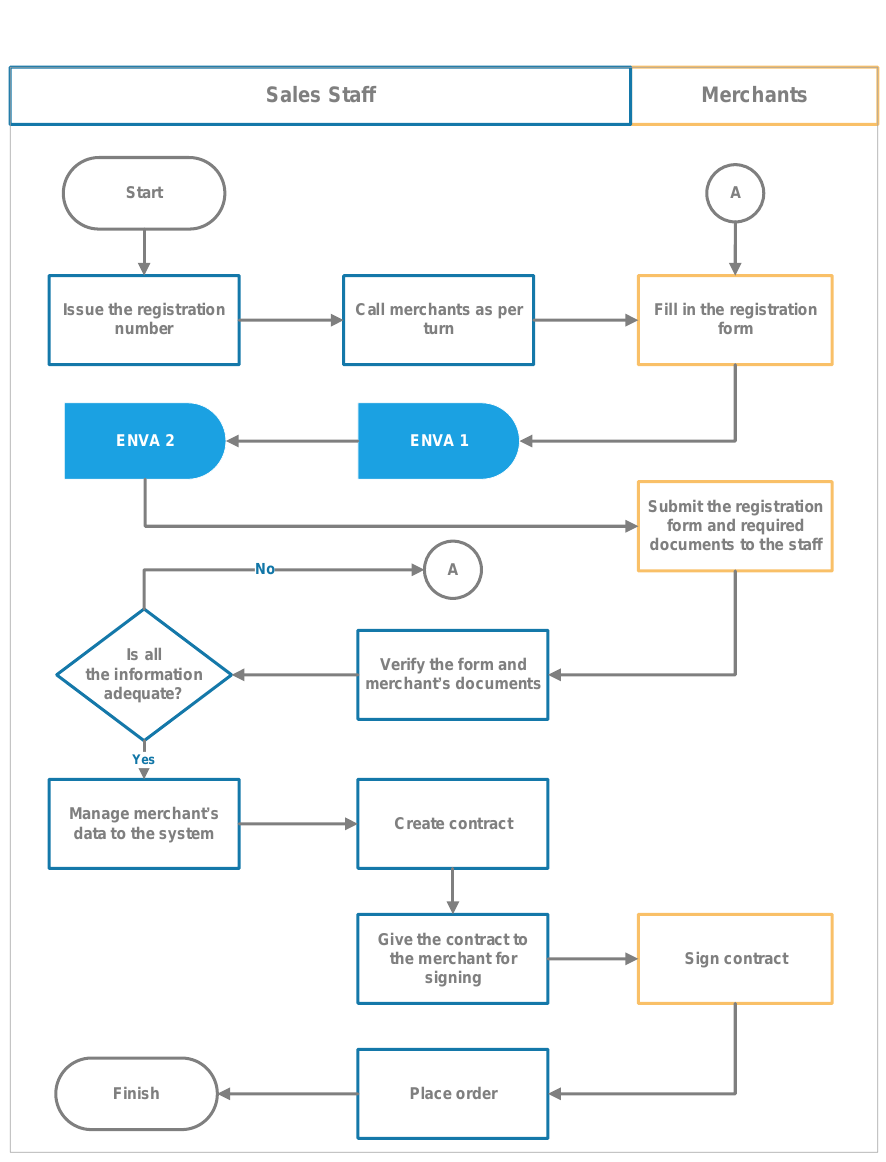
Figure 6. Process flow chart for the onboarding